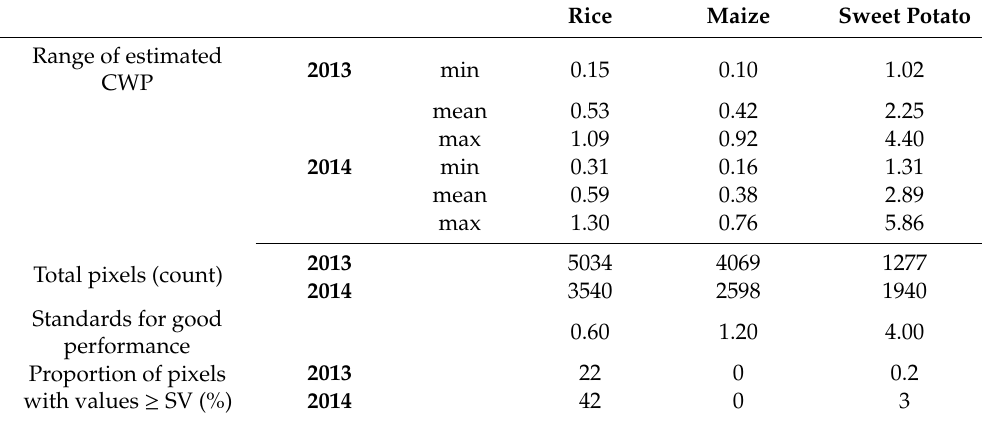
Figure 12. Spatial distributions of estimated crop water productivity for paddy rice, maize, and sweet potato across the Kou Valley irrigation scheme during the dry season production period in 2013 and 2014. Table 5. Ranges of estimated crop water productivity (CWP), and proportions of crop areas with good irrigation performance in terms of CWP for rice, maize, and sweet potato in the Kou Valley irrigation scheme during the dry season production periods in 2013 and 2014.